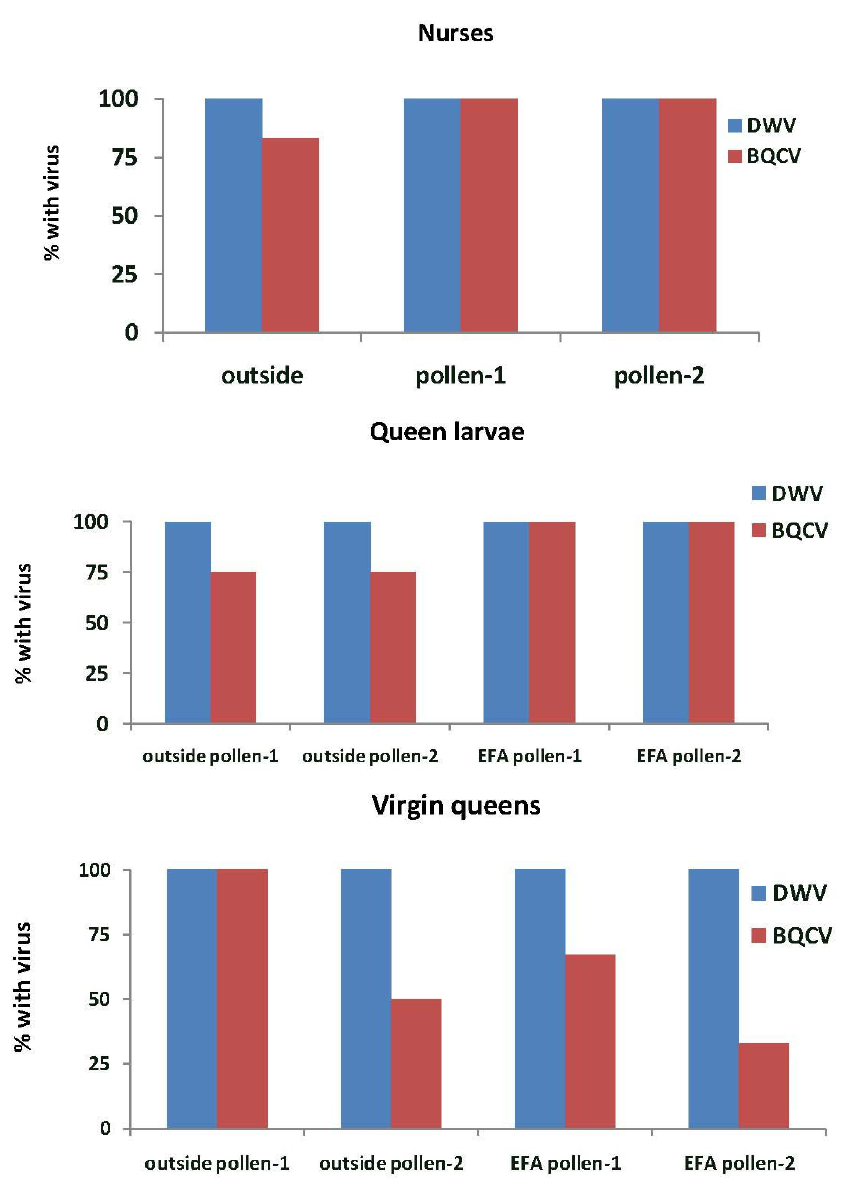
Figure 6. Nurse bees, queen larvae and virgin queens with deformed wing virus (DWV) and Black queen cell virus (BQCV). Samples were taken from open foraging colonies in an apiary (outside) or foraging in an enclosed flight are (EFA) and fed pollen with chlorpyrifos ® alone (pollen-1) or with added Pristine fungicide (pollen-2). The nurse bees were sampled while tending the queen cells containing the queen larvae that were tested. Percentages are based on samples of 12 nurse bees, three queen larvae, and three virgin from each treatment group. The exception was outside larvae reared in colonies fed pollen-2 where two virgin queens were